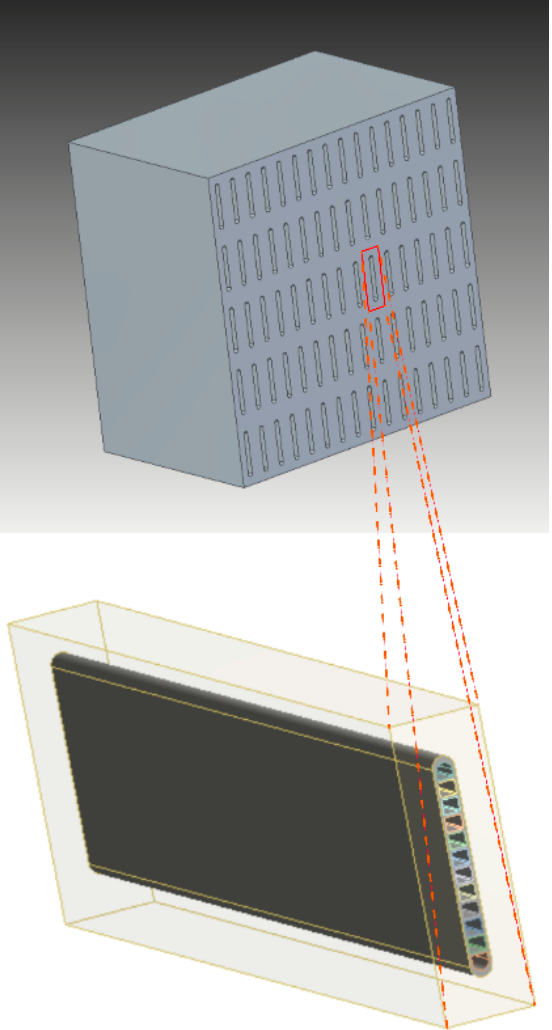
Figure 1. The physical model and the simulation domain.